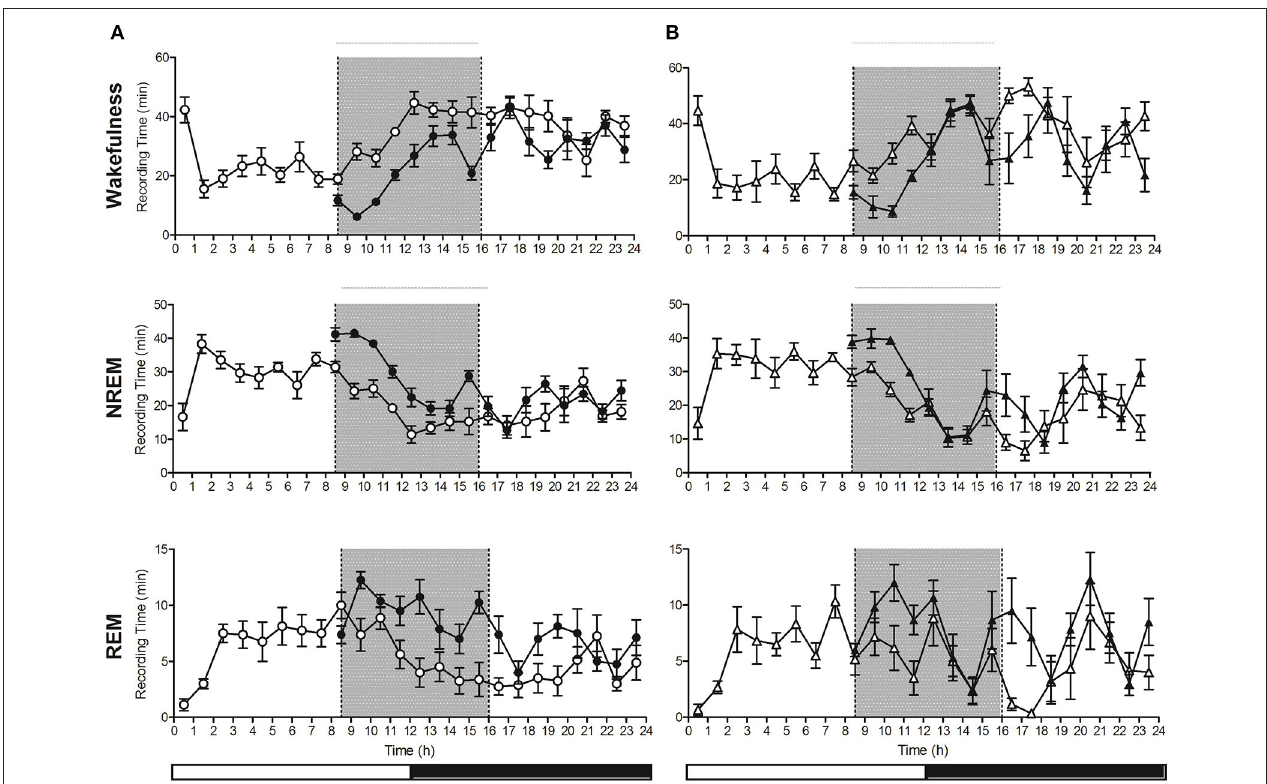
FIGURE 4 | Hourly distribution of the time (minutes; mean ± SEM) spent in Wakefulness/NREM/REM at baseline (open symbols) and during the recovery period (closed symbols) in control ( A ; n = 8, circles) and hyperammonemic rats ( B ; n = 6, triangles). Analysis of recovery was performed on both the 9–16 h (gray portion of the graphs) and 9–24 h intervals. Statistical analysis of wakefulness, NREM and REM (presented in Table 1 ), was performed by comparing the differences between baseline and sleep deprivation in the control group (A) as well as baseline and sleep deprivation in the ammonium-treated group (B) [repeated measures ANOVA of the mathematical difference between baseline and recovery (in minutes), by group; Table 1 ].